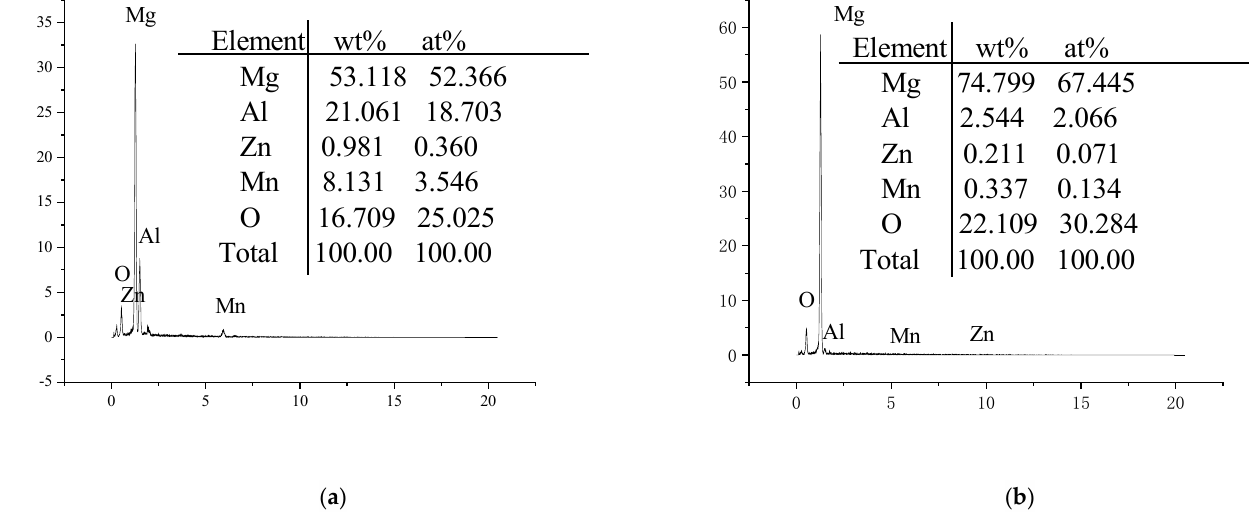
Figure 5. EDS analysis of inclusion in AZ80 alloy. ( a , b ) correspond to Figure 4.